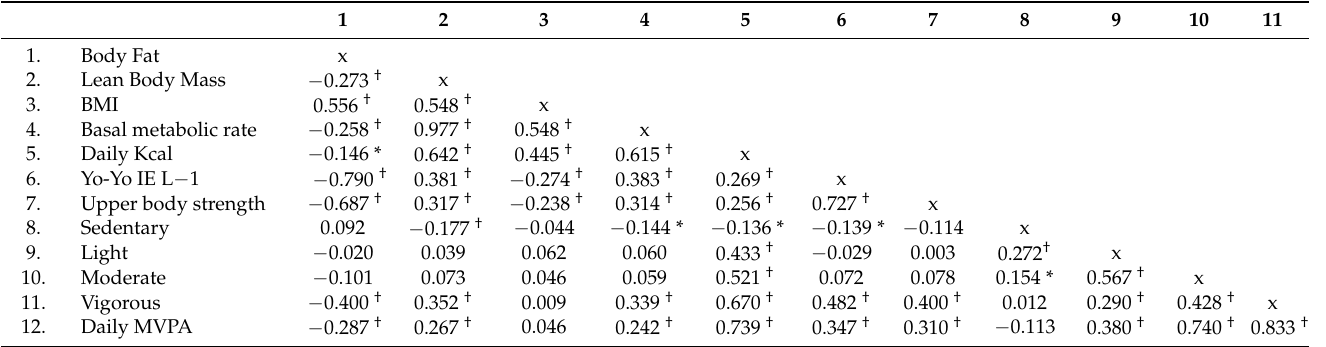
Table 2. Correlations among study